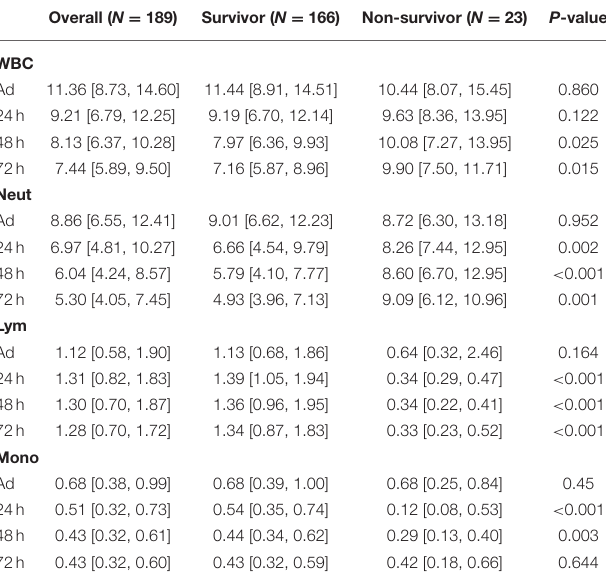
the ratio ( Figure 3B ) on the prognosis of patients with EHS. Neutrophil counts and ratios at 24 h, 48 h, and 72 h showed hazard ratio (HR) over 1. At 24 h, the HR of the monocyte count was 0.020 (95% CI:0.002–0.171, p < 0.001). The HR